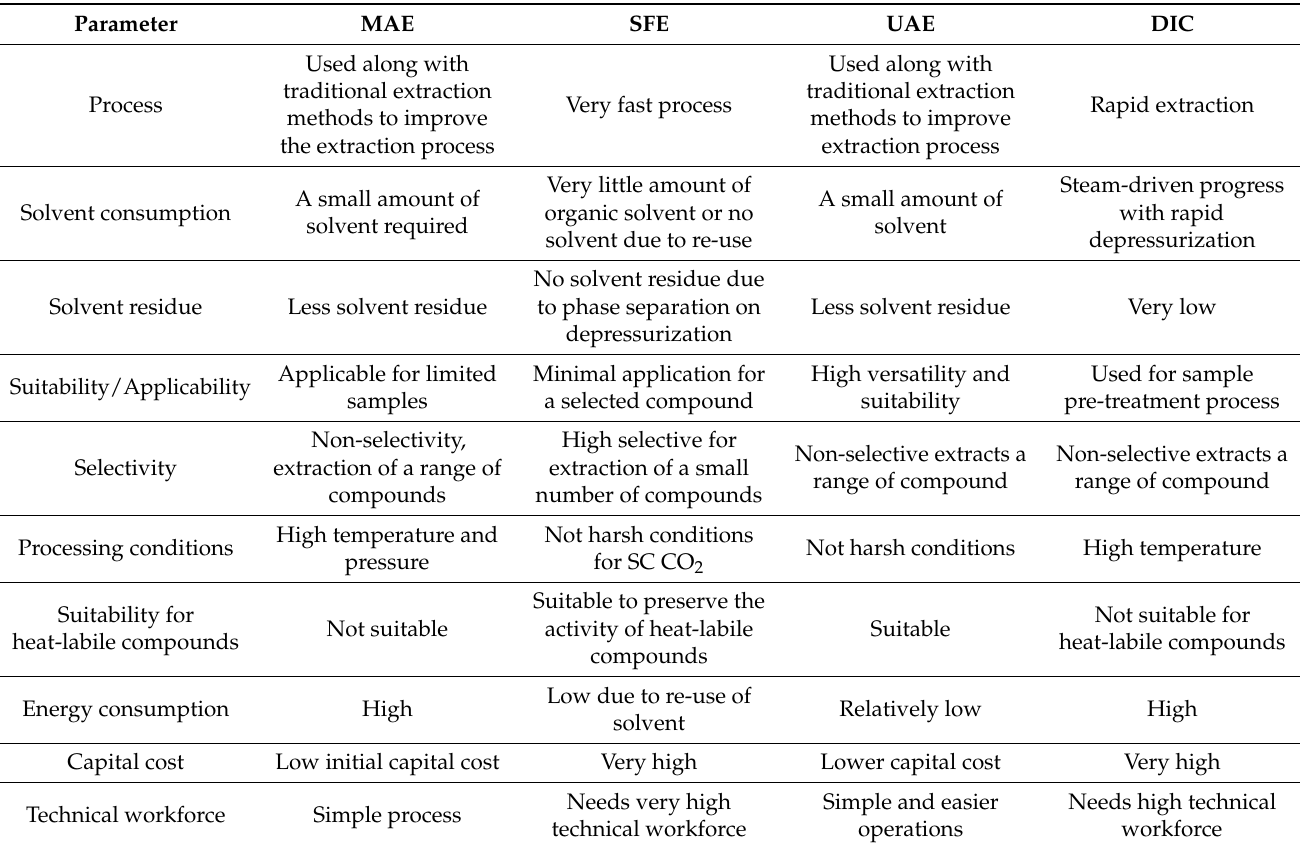
Table 1. Technological aspects of various green extraction